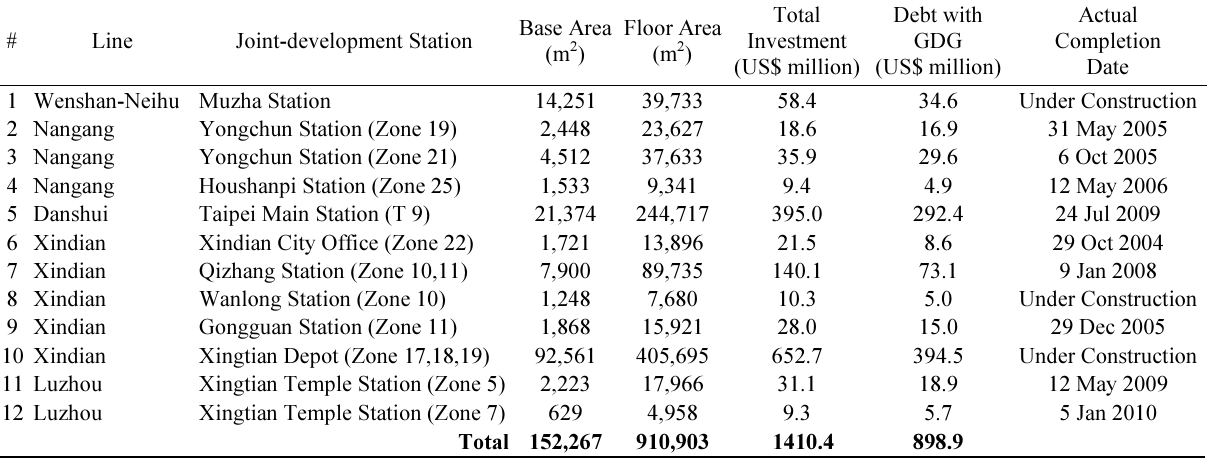
Table 1. List of Taipei MRT station joint-development projects with assistive financing mechanism (until the end of 2010) #